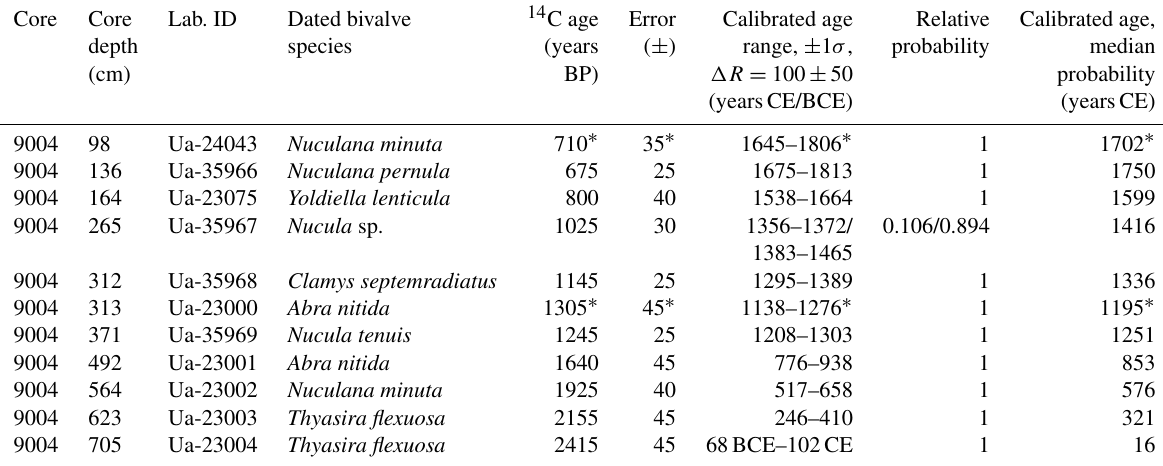
∗ Dates not used in the final age model due to age